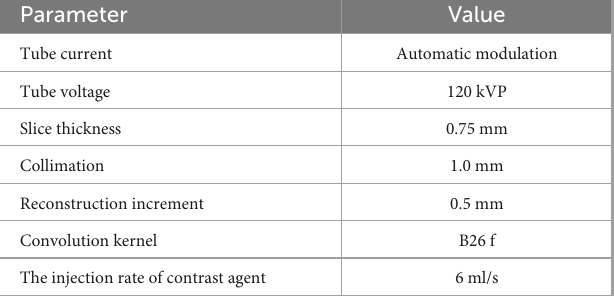
TABLE 1 The scanning parameters of coronary computed tomography angiography